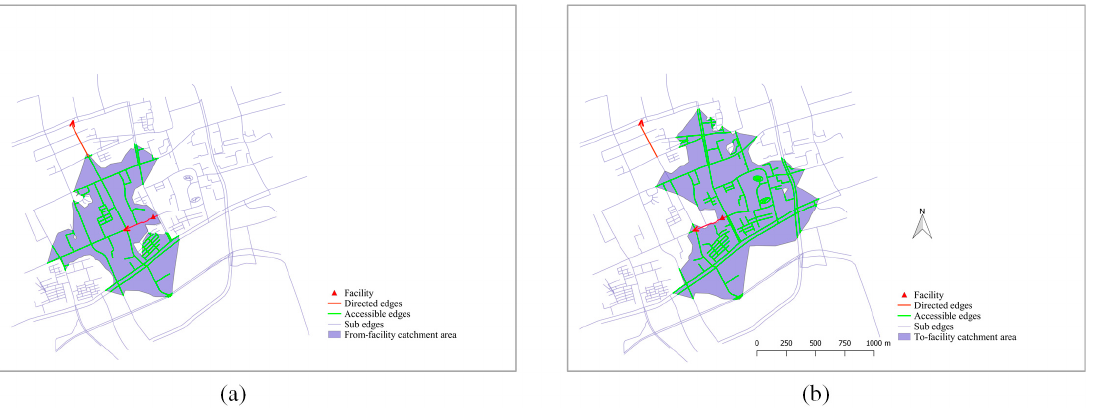
Figure 9. The from-facility ( a ) and to-facility ( b ) catchment area of a point facility based on a directed road